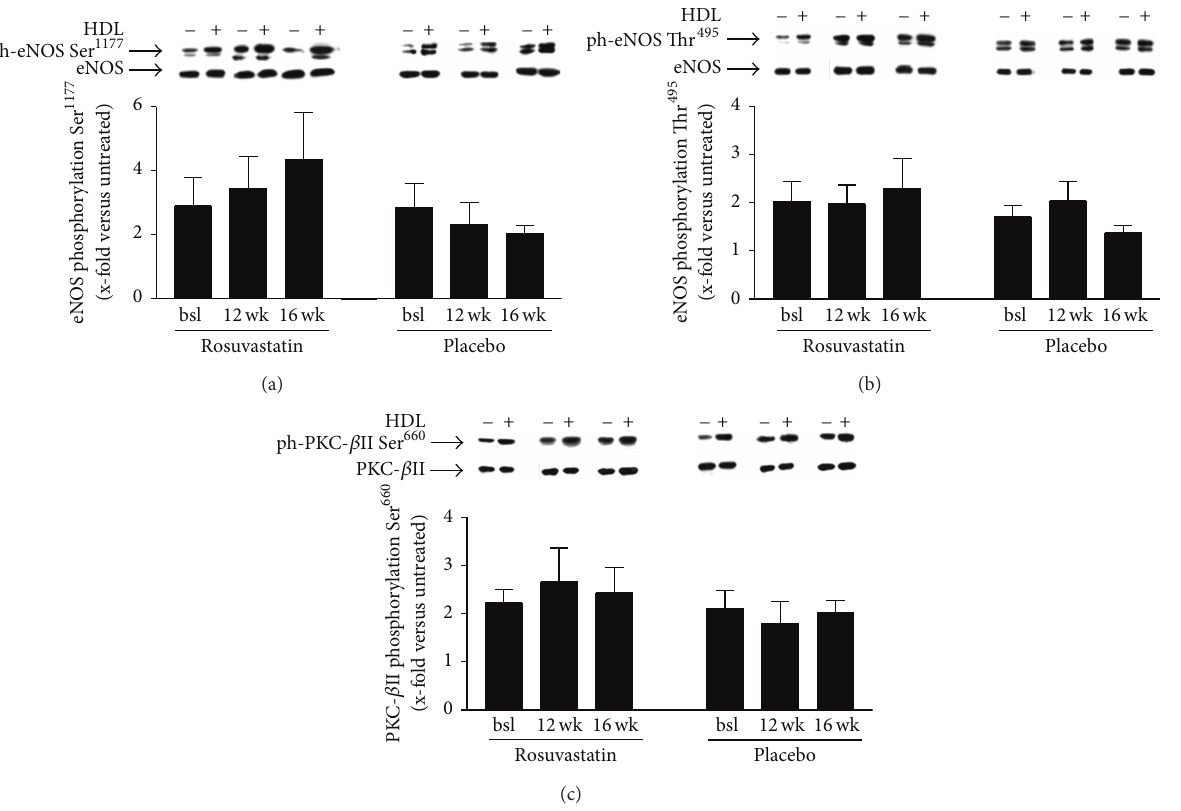
Figure 1: (a) X-fold increase in eNOS phosphorylation at Ser 1177 of human aortic endothelial cells stimulated with HDL from patients treated with rosuvastatin or placebo versus unstimulated cells. (b) X-fold increase in eNOS phosphorylation at Thr 495 of human aortic endothelial cells stimulated with HDL from patients treated with rosuvastatin or placebo versus unstimulated cells. (c) X-fold increase in PKC- 𝛽 II phosphorylation at Ser 660 of human aortic endothelial cells stimulated with HDL from patients treated with rosuvastatin or placebo versus unstimulated